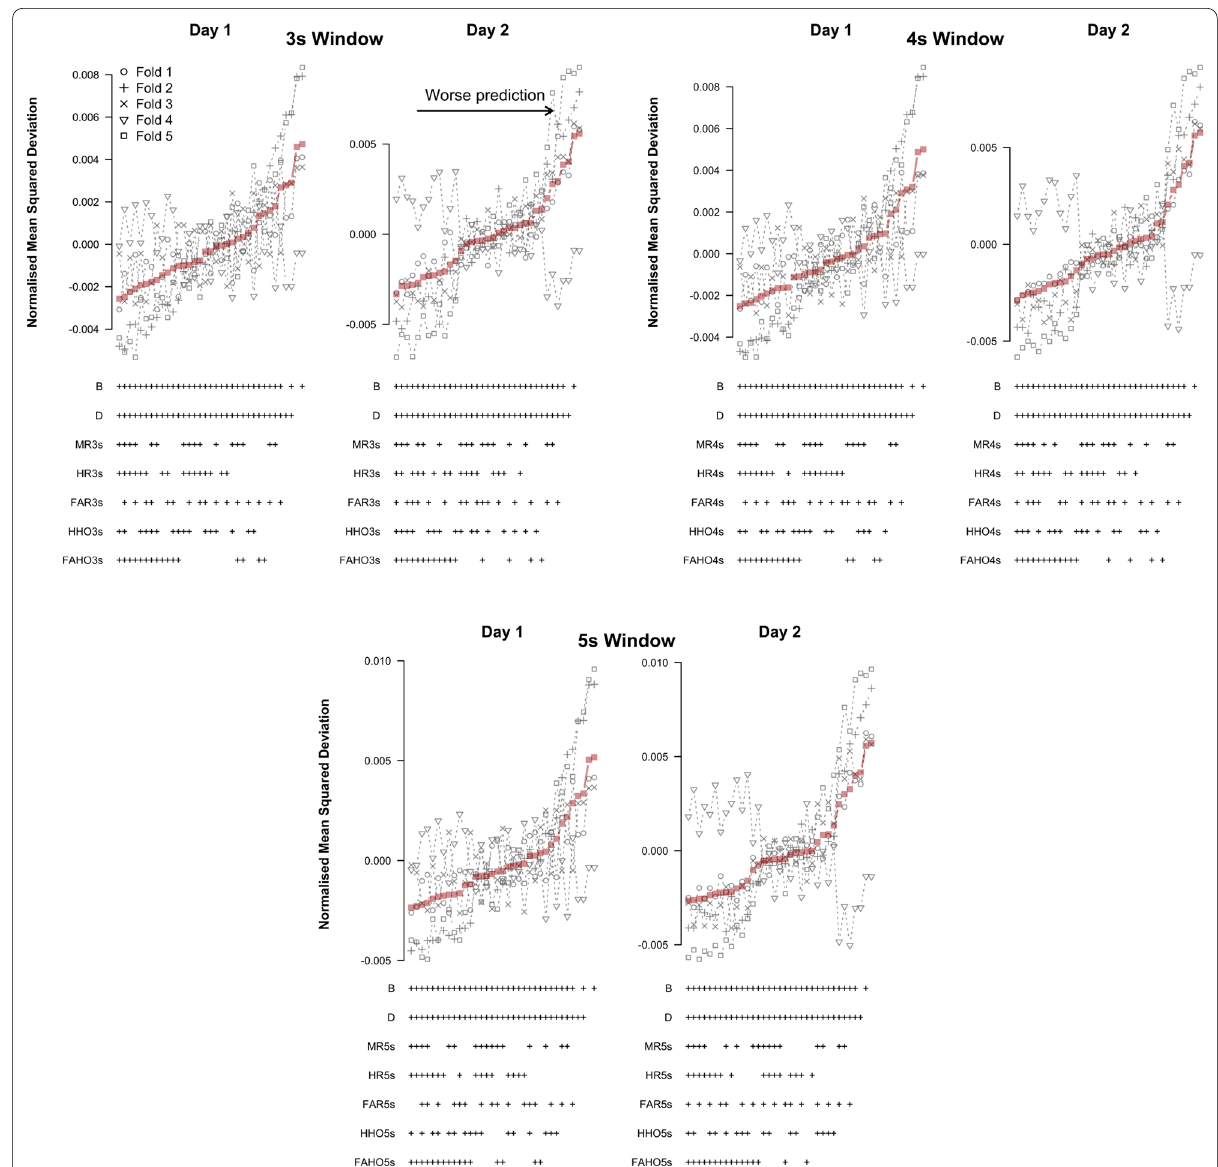
Fig. 8 Cross-validation results based on LMMs for different UAV-task event predictors of log-RT. Normalized mean squared deviations for different LMMs for different time windows prior to the DRT prompt are shown. Top row: 3-s time window; middle row: 4-s time window; bottom row: 5-s time window. Left column: results for day 1; right column: results for day 2. Red squares show the mean across